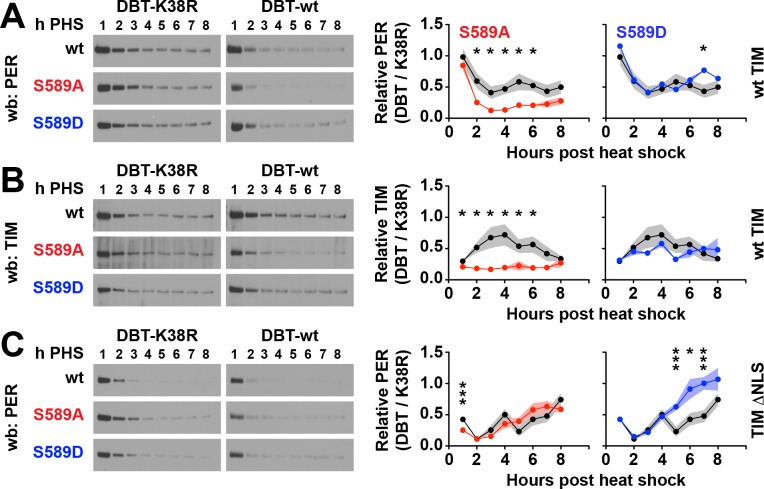
Residue substitutions of S589 determine PER/TIM stability in cultured cells.S2 cells expressing per driven by a heat-shock promoter, and dbt and tim driven by actin promoter were collected each hour post heat shock (h PHS) in a pulse-chase experiment using cycloheximide. (A) Wild type, S589A or S589D per variants were co-expressed in S2 cells with wild type (wt) TIM and either wild type DBT (DBT-wt) or mutant DBT lacking ATPase activity (DBT-K38R). Representative western blots (wb) are shown. PER signal was quantified and normalized to either DBT-wt or DBT-K38R signal, and the ratios plotted. S589A (red) and S589D (blue) was compared to wild type PER (black). N = 4. Each data point represents the mean, ±SEM. Thickness of the curve reflects SEM. *p<0.05. ***p<0.005. Data points without asterisks are not statistically significant. Significance was measured by t-test. (B) The same analysis conducted in panel A was repeated for TIM co-expressed with PER, S589A or S589D, and DBT-wt or DBT-K38R. (C) The same analysis conducted in panel A was repeated for PER, with a mutant form of TIM lacking a nuclear localization signal (TIM ΔNLS).